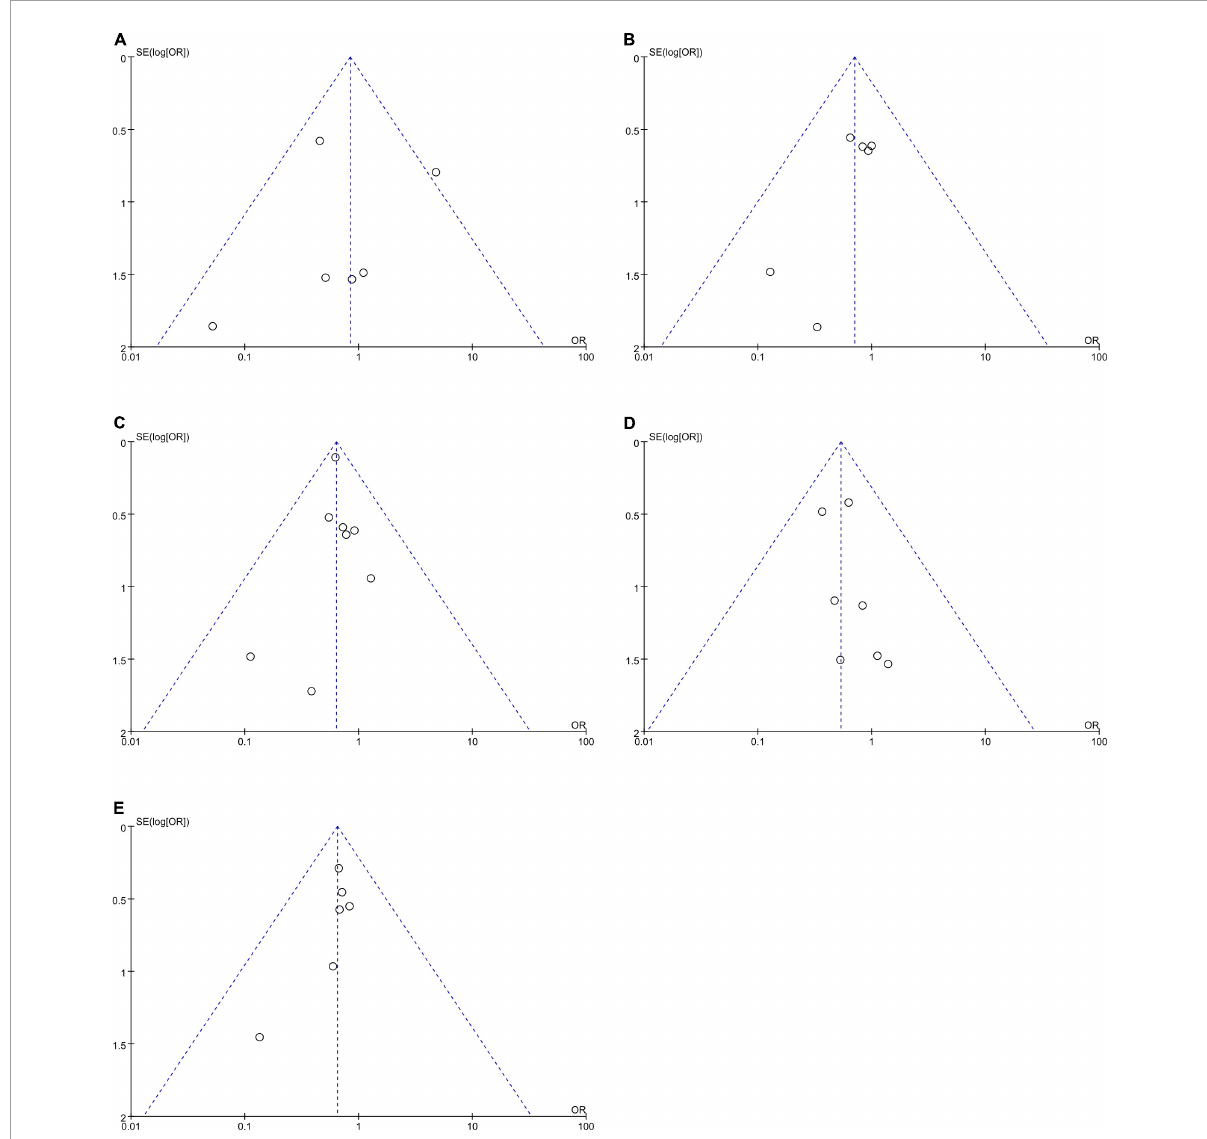
FIGURE6 Funnel plots to assess the publication bias related to the risk of bleeding: (A) homozygote model, (B) heterozygote model, (C) dominant model, (D) recessive model, and (E) allelic